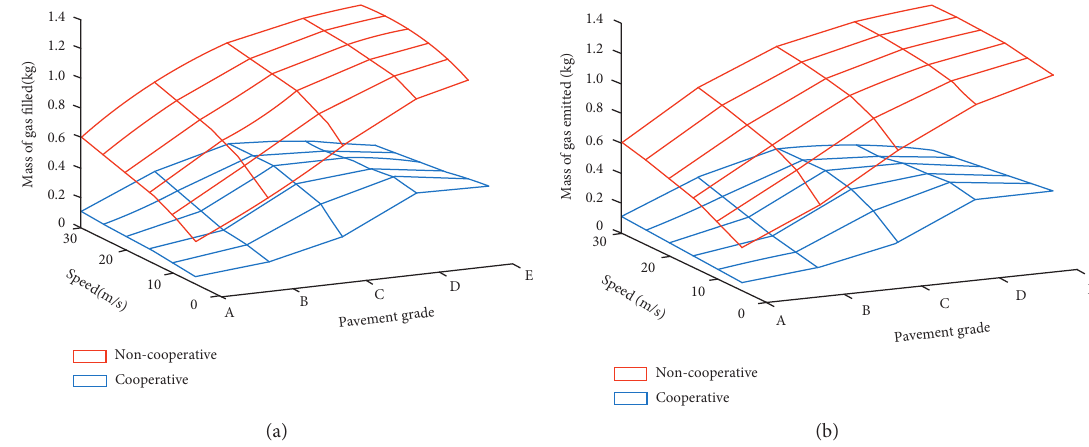
Figure 14: Energy consumption of cooperative control and noncooperative control. (a) Mass of gas filled. (b) Mass of gas